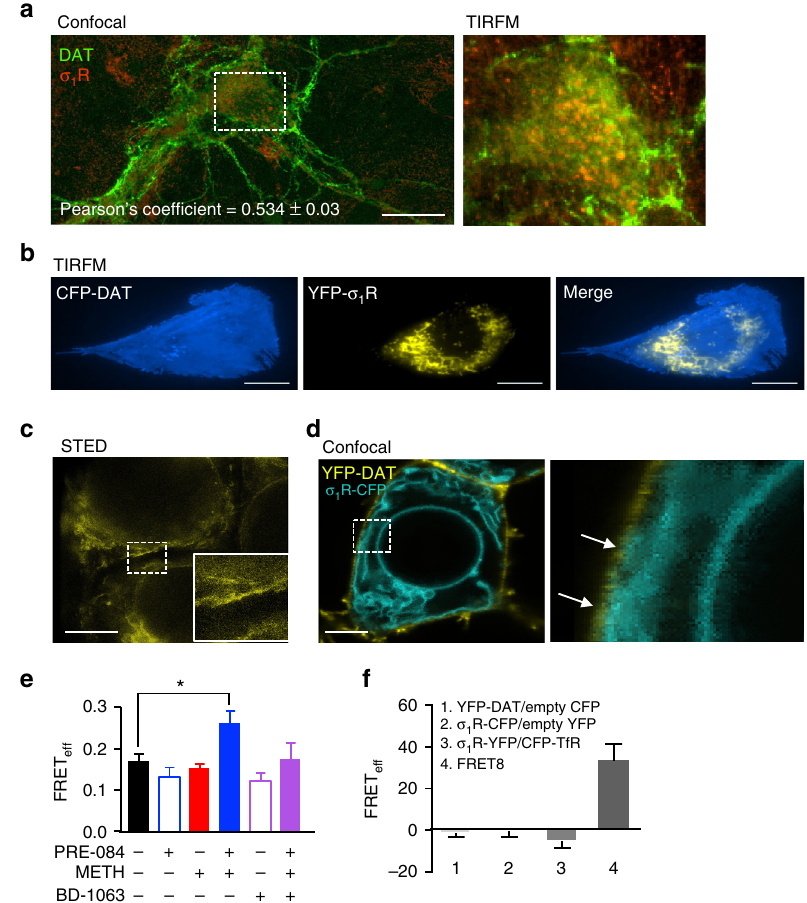
Fig. 9 σ 1 R is co-localized with the dopamine transporter at or near the plasma membrane. a Representative confocal image of immunolabeled endogenous DAT (green) and endogenous σ 1 R (red) in primary culture of dopaminergic neurons shows DAT and σ 1 R are co-localized (shown in orange). The Pearson ’ s coef fi cient = 0.534 ± 0.03, n = 24 neurons (scale bar: 25 μ m). Total internal re fl ection fl uorescence microscopy (TIRFM) imaging of the neuronal cell body shows co-localization occurring at or near ( < 150 nm) the plasma membrane (right panel). b TIRFM imaging of cells expressing CFP-DAT and σ 1 R-YFP reveals localization of the two proteins at or near the plasma membrane (scale bar: 25 μ m). c Super-resolution STED microscopy of σ 1 R-YFP expressing cells. The inset shows a 200% magni fi cation of the indicated region revealing a σ 1 R-YFP hot-spot at the cellular edge (scale: 5 µ m). d YFP-DAT cells expressing σ 1 R-CFP shows areas of the endoplasmic reticulum (as indicated by σ 1 R-CFP expression) in close contact with the plasma membrane (as indicated by YFP-DAT expression; scale bar 25 µ m). The right panel shows a 500% magni fi cation of the indicated region. Arrows highlight the areas of contact between σ 1 R-CFP and YFP-DAT. e FRET ef fi ciency (FRET eff ) analysis reveals an interaction between σ 1 R-CFP and YFP-DAT. While 1 μ M PRE-084 (30 min), 1 μ M BD-1063 (30 min), or METH (10 μ M, 15 min) alone did not increase the FRET eff compared to control, combined PRE-084 and METH treatment signi fi cantly increased the association between σ 1 R-CFP and YFP-DAT as measured by an increased FRET eff. 1 μ M BD1063 pretreatment before PRE-084/METH blocked the effect of PRE-084. ( n = 10 – 19 cells per group; F (5,75) = 2.4, P = 0.0005, one-way ANOVA; Tukey ’ s test for multiple comparisons; P = 0.1694 comparing PRE-084/METH to BD1063/PRE-084/METH). f Nonspeci fi c FRET was determined in cells expressing YFP-DAT/ empty CFP-vector or σ 1 R-CFP/YFP-vector ( n = 5 cells). Additionally, σ 1 R-YFP co-expressed with CFP-transferrin receptor (CFP-TfR) did not result in detectable FRET ( n = 4 cells). For positive control, the CFP-YFP fusion protein FRET8 was used ( n = 5 cells). ** P < 0.01. Data is represented as mean ±